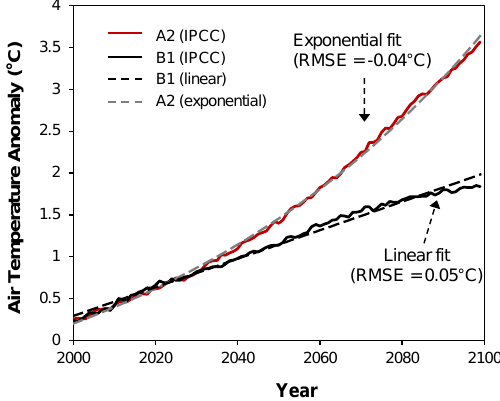
Figure 2. IPCC multi-model globally averaged air temperature anomaly projections for the twenty-first century relative to the air temperature data for 1980–1999 for emission scenarios B1 and A2 (data from, IPCC, 2007). Details concerning the exponential and linear fits to the IPCC projections are given in Sect. 3.3.1. Modified from Kurylyk and MacQuarrie (2014).